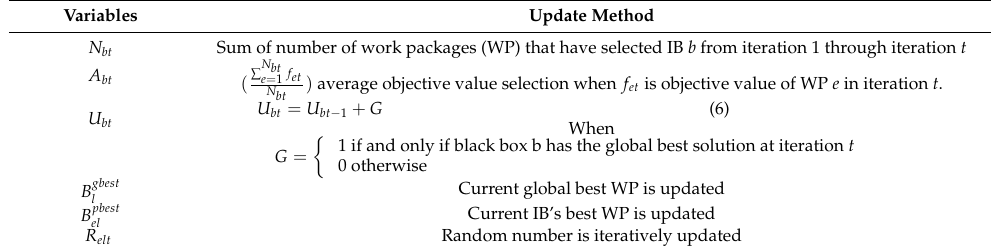
Table 13. Update method of heuristics information.